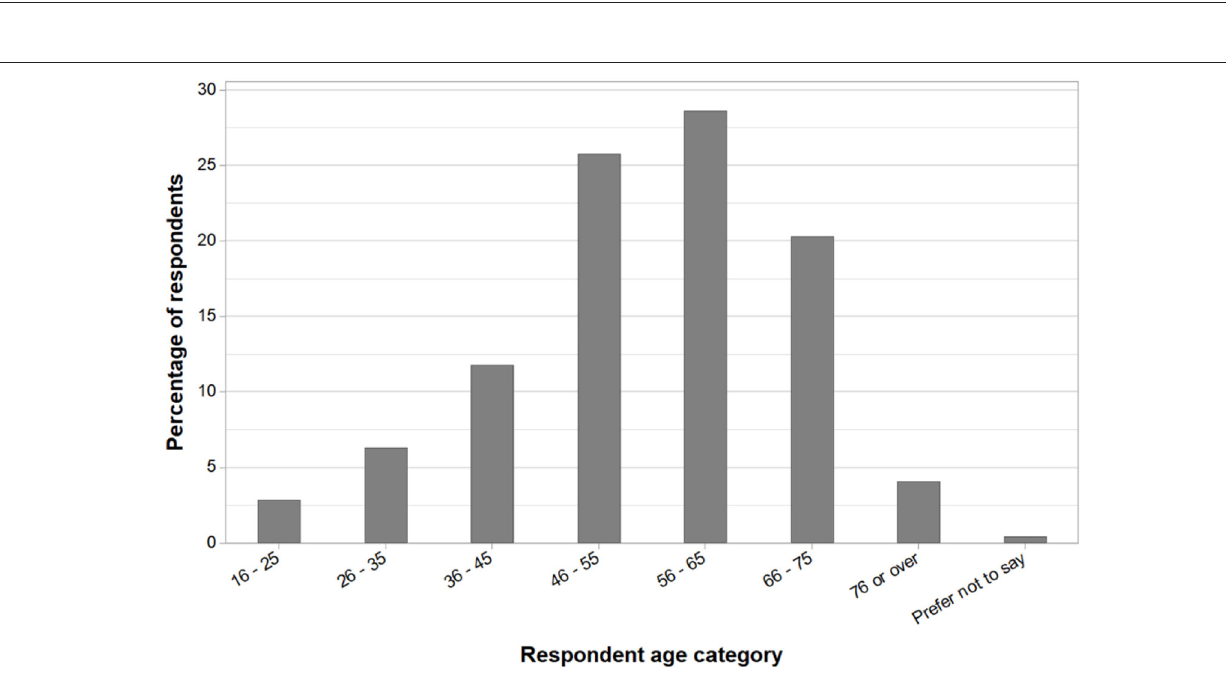
examination was considered not possible by 31% (156/510) and 32% (163/511) of farmers for front and back feet,